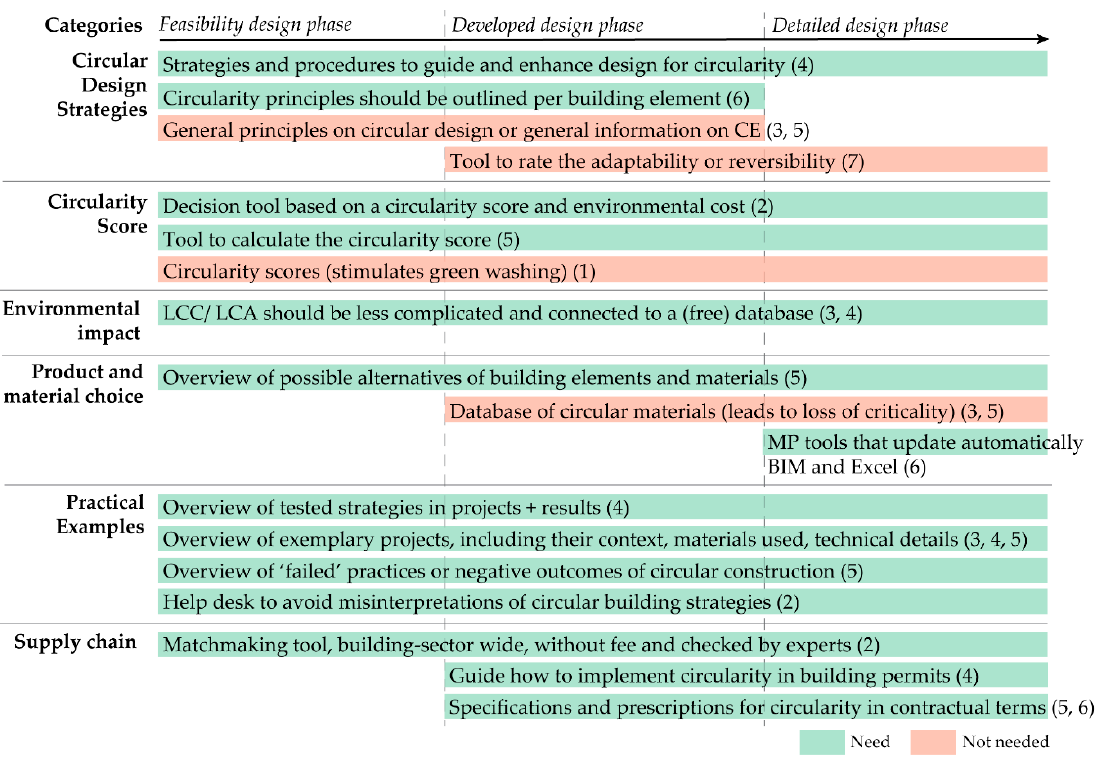
Figure 3. Framework 2: Categorisation of the building designers’ and advising engineers’ needs for tools for circular building per design phase and per design tool category (green bars). Related interviews are indicated as: (1) researcher sustainable buildings; (2) facade contractor/designer; (3) architect (engineering office); (4) sustainability engineer; (5) architects; (6) architect; (7) architect.